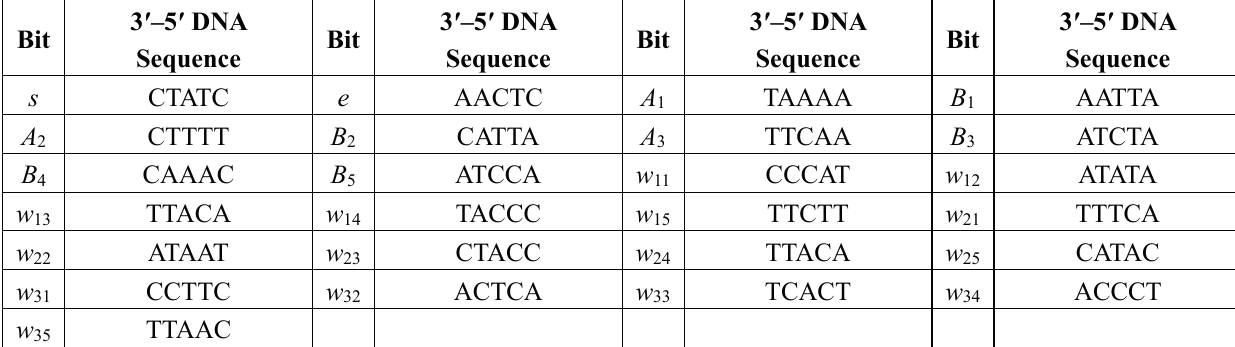
Table 8. Sequences chosen to represent s , e , A k , B k , and w ij in the example for Table 1.